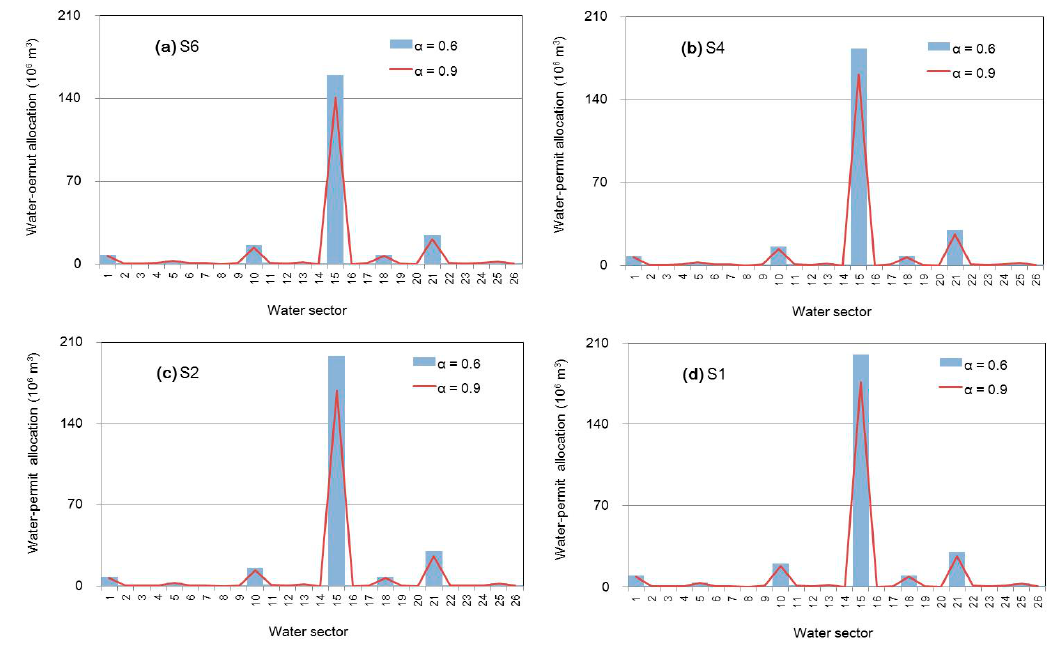
Figure 7. Optimal water-rights allocation for industrial users under various scenarios (figure ( a ) presents optimal water-right allocation under S6; figure ( b ) presents optimal water-right allocation under S4; figure ( c ) presents optimal water-right allocation under S2; figure ( d ) presents optimal water-right allocation under S1;)